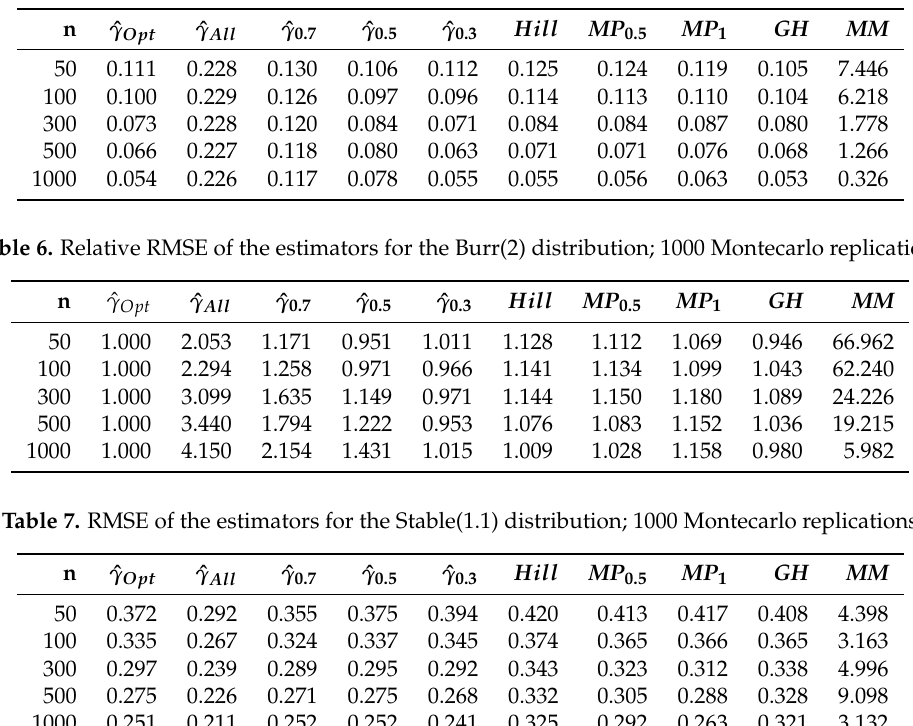
Table 5. RMSE of the estimators for the Burr(2) distribution; 1000 Montecarlo replications.